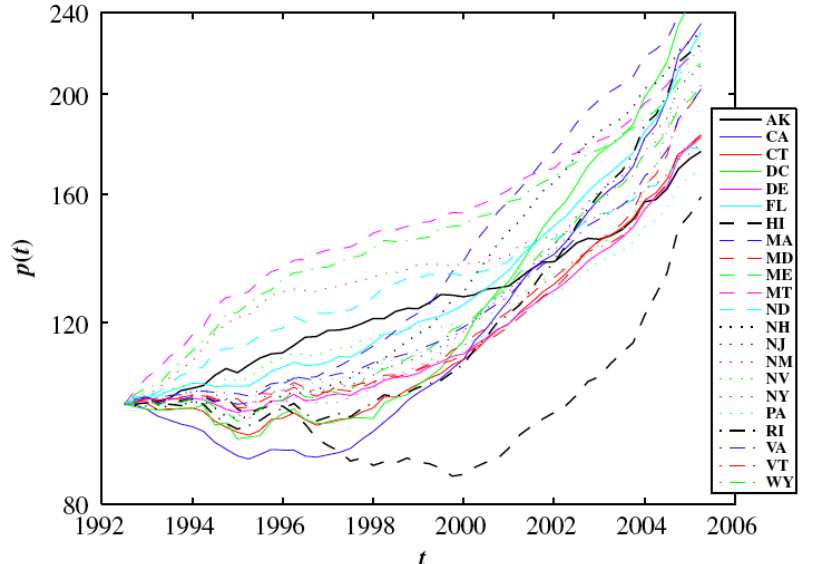
Figure 12. Quarterly average House Price Index (HPI) in the 21 states and in the District of Columbia (DC) where Zhou and Sornette diagnosed bubble-type behaviors in June 2005 and predicted a peak in mid-2006 [18]. For comparison, the HPI has been normalized to 100 at the second quarter of 1992. The corresponding U.S. state abbreviations are given in the legend on the